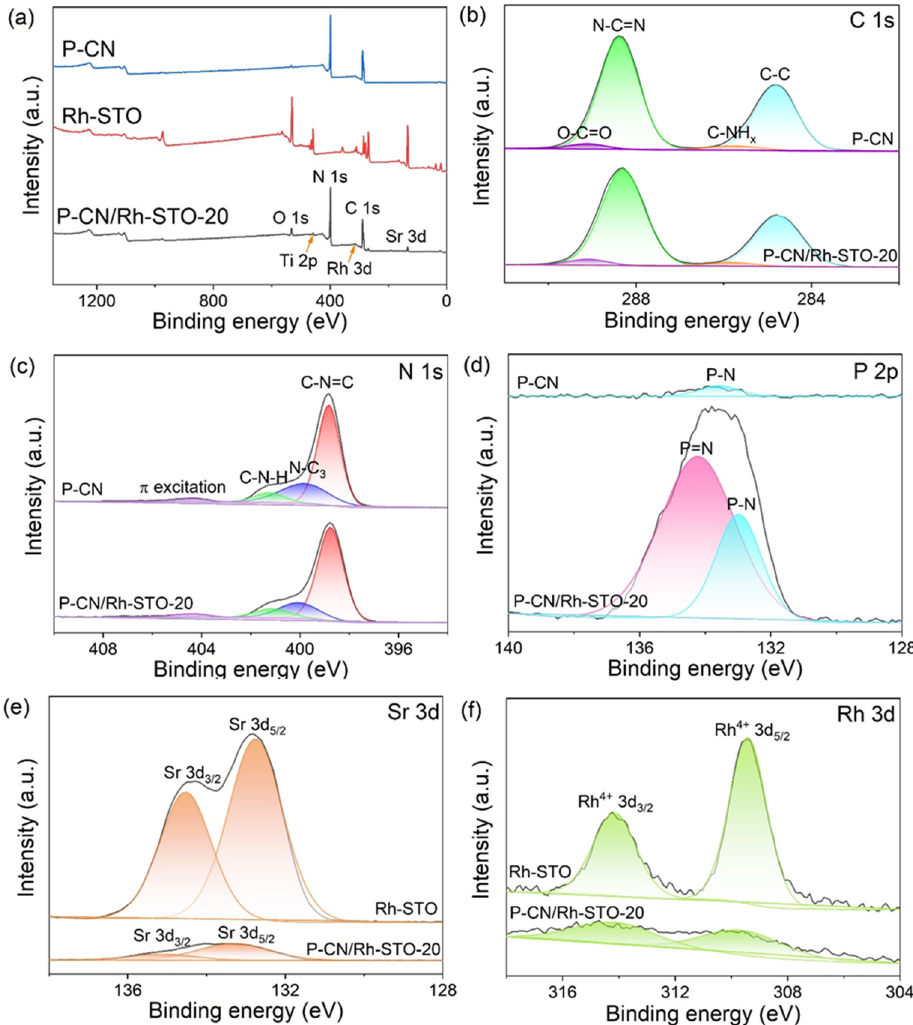
Figure 4. ( a ) XPS survey spectra of P-CN, Rh-STO, and P-CN/Rh-STO-20; ( b ) C 1s XPS spectra, ( c ) N 1s XPS spectra, and ( d ) P 2p XPS spectra of P-CN and P-CN/Rh-STO-20; ( e ) Sr 3d XPS spectra and ( f ) Rh 3d XPS spectra of Rh-STO and P-CN/Rh-STO-20, respectively.